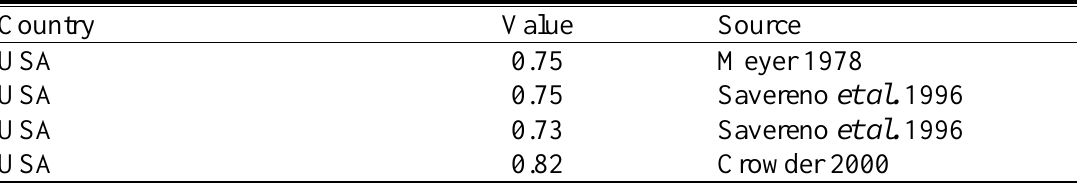
Table A2.3. Crippling bias values used to calculate standardized mortality rates. Values represent the number of birds colliding with wires that fall outside the search